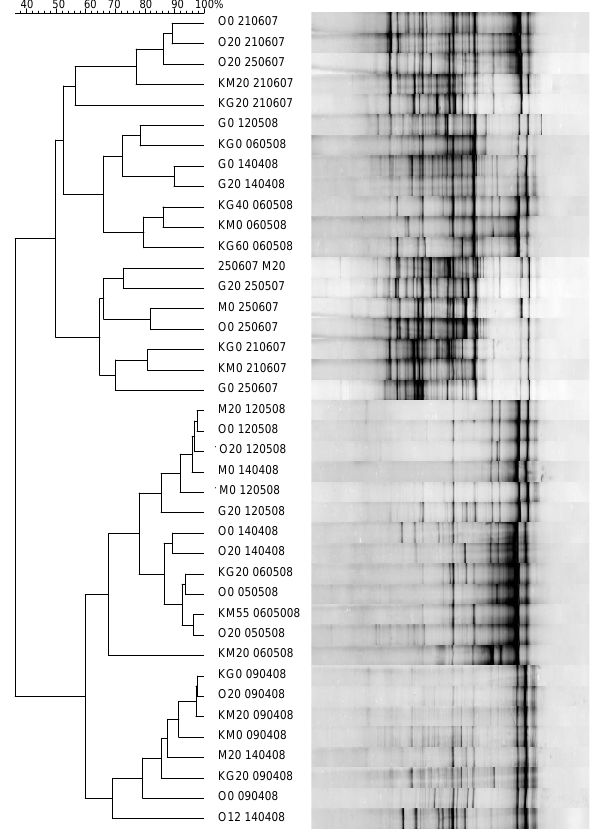
Figure 6. Dendrogram of DGGE profiles of PCR-amplified 18S rRNA gene fragments from temporal selection of the five sampling locations. The samples were selected according to the maximal temporal range covered by the two field campaigns (early April, early May and end of June). Cluster analysis was based on Pearson’s correla- tion index and the unweighted pair-group method with arithmetic